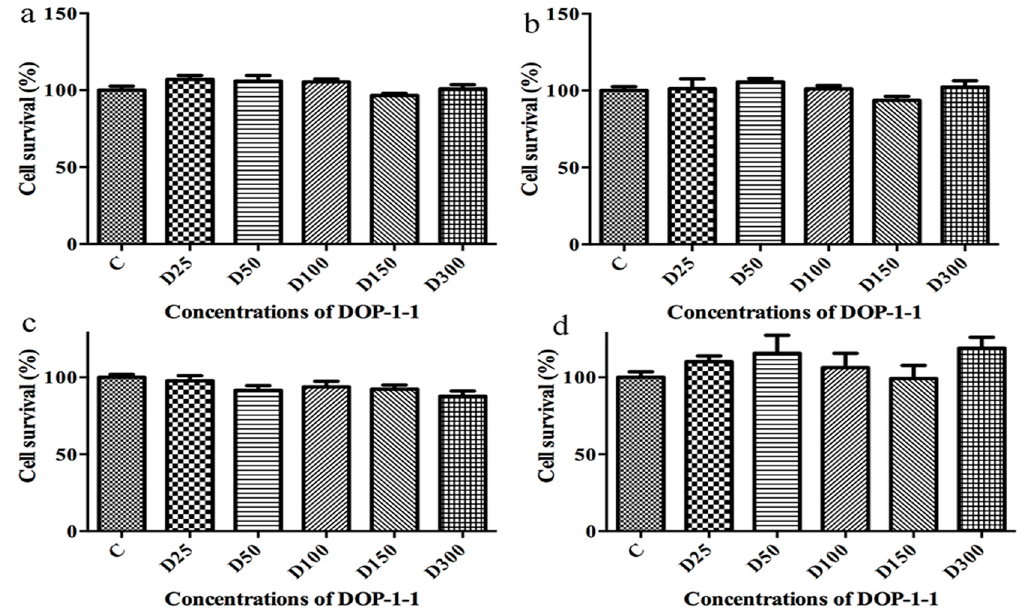
Figure 3. Effects of DOP-1-1 at different concentrations on the survival of mature macrophages differentiated from THP-1 cells by MTT assay. ( a ) 12 h, ( b ) 24 h, ( c ) 36 h, ( d ) 48 h (D25, D50, D100, D150, D300 means 25, 50, 100, 150, 300 µ g/mL of DOP-1-1. The data were expressed as mean values ± SD).